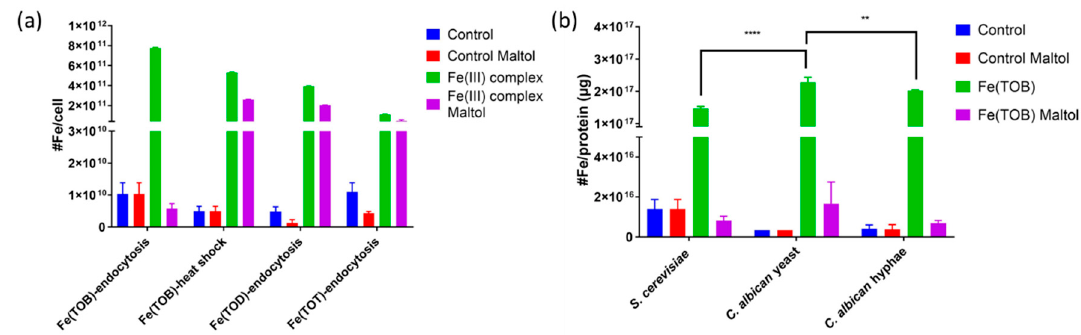
Figure 3. Total Fe content in yeast cells during ( a ) endocytosis and heat treatment with 10 mM Fe(TOB) complexes, endocytosis labeling with 10 mM Fe(TOD), and endocytosis labeling with 10 mM Fe(TOT) in S. cerevisiae ; ( b ) endocytosis labeling of 10 mM Fe(TOB) treatment with S. cerevisiae , C. albicans yeast, and C. albicans hyphae, as measured using ICPMS. Mean ± SE is reported, **** p < 0.0001 and ** p < 0.001, n = 3.